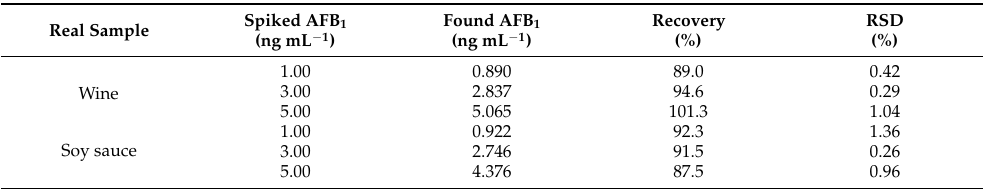
Table 2. Recovery of high-concentration AFB 1 in wine and soy sauce for the application of biosensors in a real matrix.